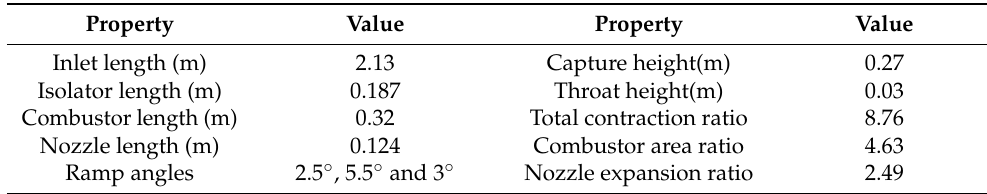
Table 1. Geometric properties of the investigated hypersonic vehicle.